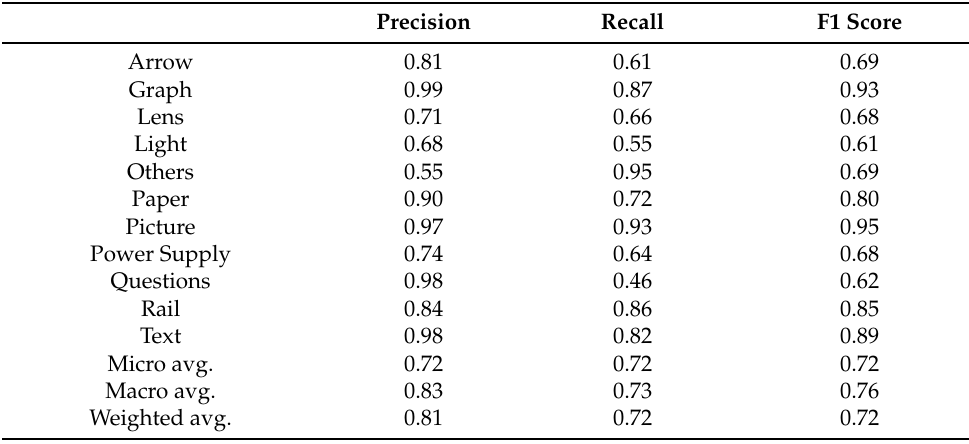
Figure 8. Confusion matrix for YOLO v4 without interpolation. Table 3. Confusion Report for Faster R-CNN with